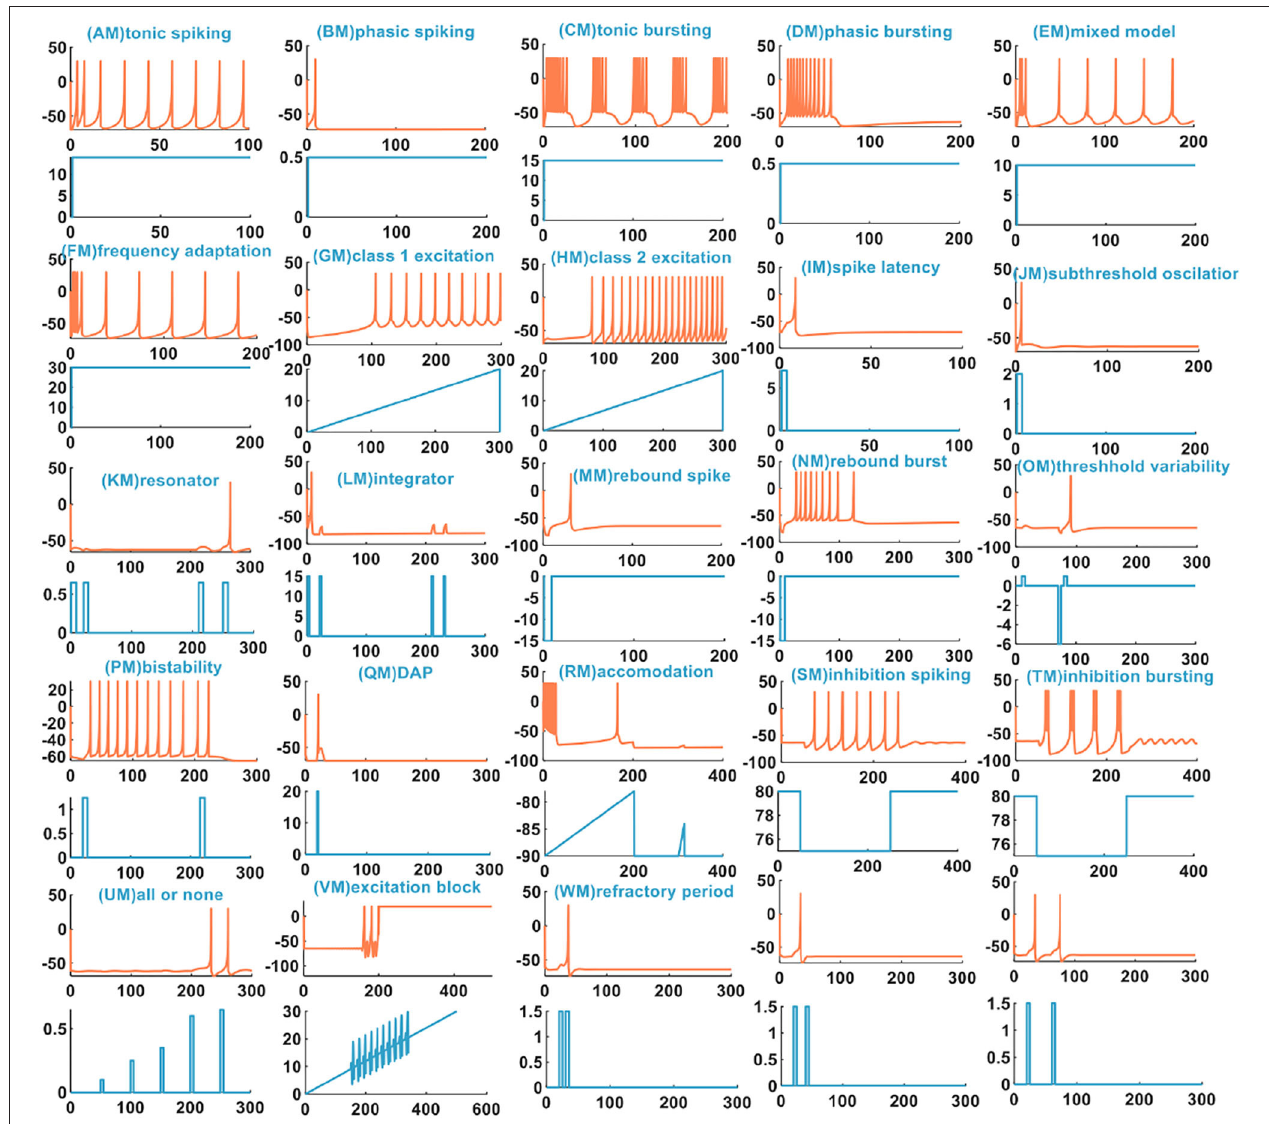
FIGURE 5 | The 23 spiking patterns are produced by the MIZH spiking